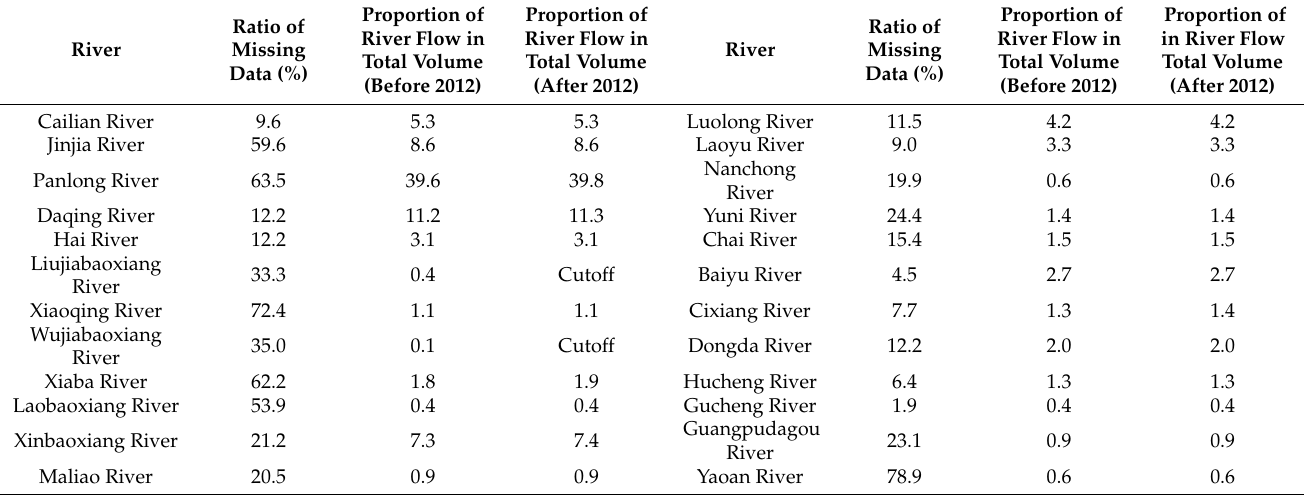
Table 2. Information of